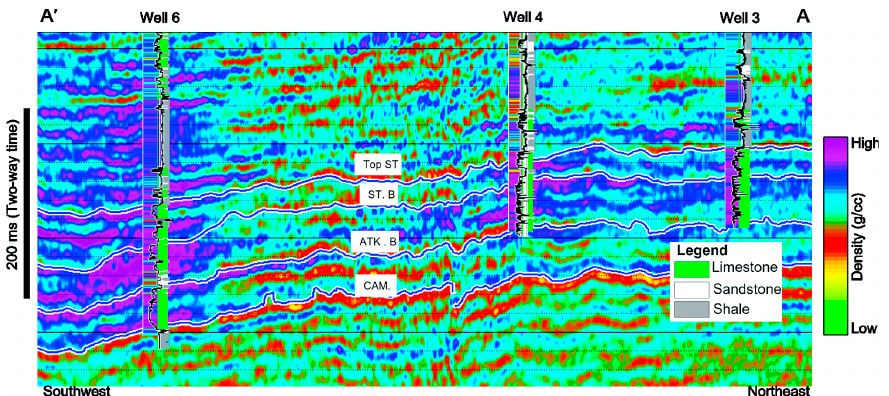
Figure 9. Cross section A–A ′ of inverted density volume passing through wells 3, 4, and 6. Note: inserted color log at well locations = actual impedance, black curve = gamma-ray log, and inserted litholog = limestone (green), sandstone (white), and shale (gray) composition. Top ST—top Strawn, ST. B—Strawn B, ATK. B—Atoka Base, and CAM.—Cambrian.